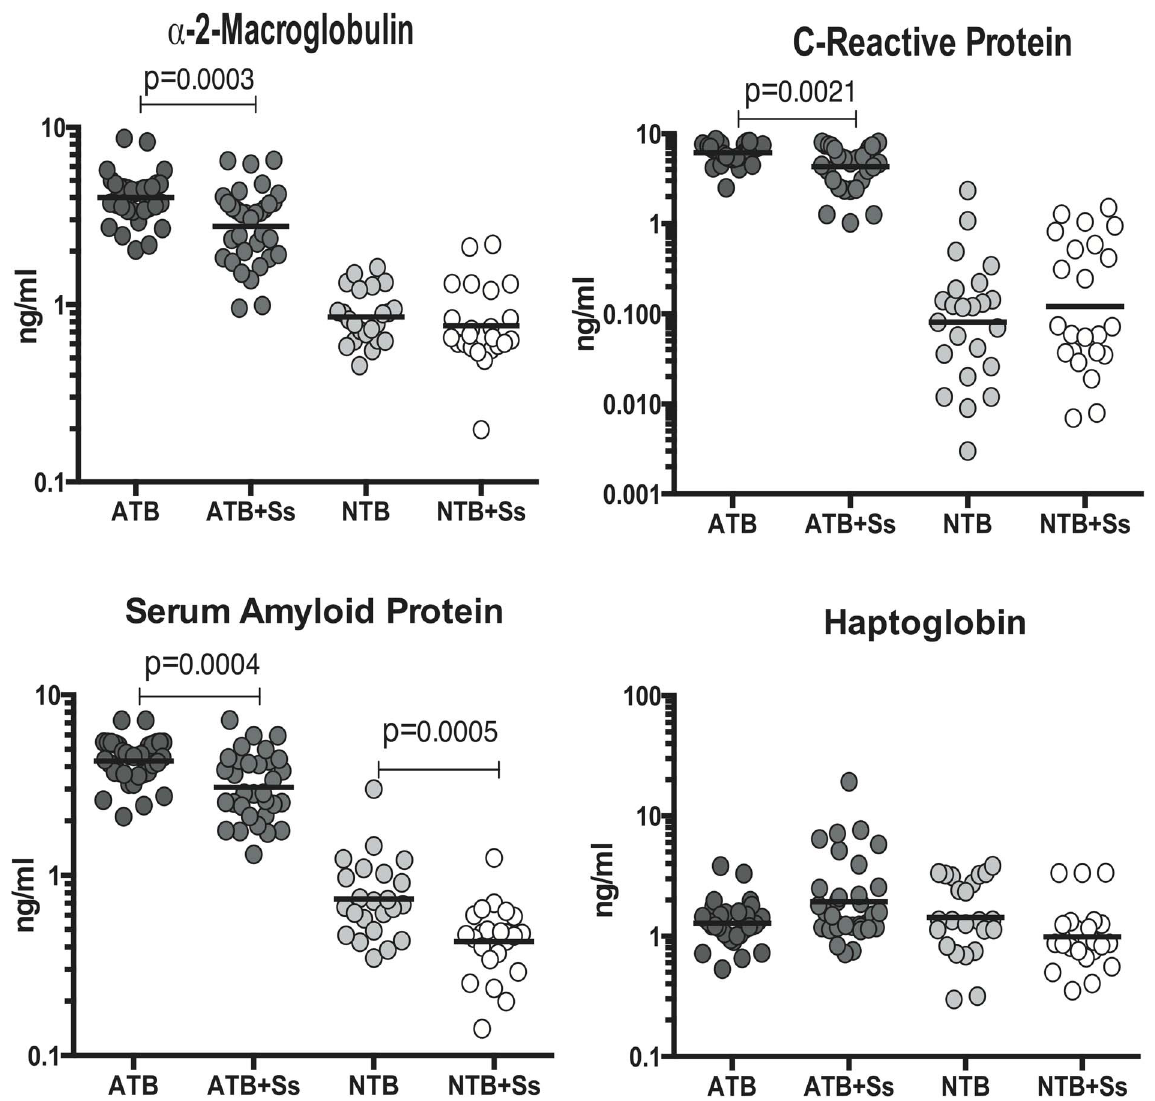
Figure 1. Helminth infections are associated with diminished plasma levels of acute phase proteins in active TB. The plasma levels of acute phase proteins - a -2M, CRP, SAA and Haptoglobin - were measured by multiplex ELISA in active pulmonary TB individuals with (ATB + Ss, n=36) or without Strongyloides coinfection (ATB, n=33) and in non-TB infected individuals with (NTB + Ss, n=23) or without Strongyloides coinfection (NTB, n=23). The results are shown as scatterplots with each circle representing a single individual and the bar representing the geometric mean. P values were calculated using the Kruskal-Wallis test with Dunn’s multiple comparisons (* p , 0.05, ** p , 0.01, *** p , 0.001, **** p , 0.0001).